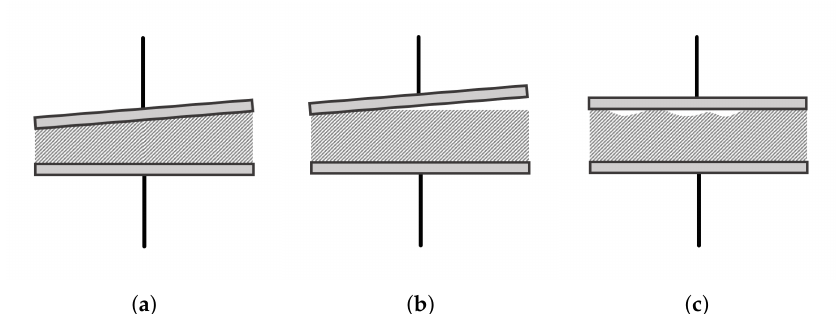
Figure 4. Qualitative representation of the possible flaws that can be encountered when measuring the electrical parameters by using a parallel-plates capacitor. Incorrect parallelism of plates with good adhesion of the material under test ( a ); incorrect parallelism of plates with the presence of an air-gap ( b ); bad adhesion of the material under test ( c ).